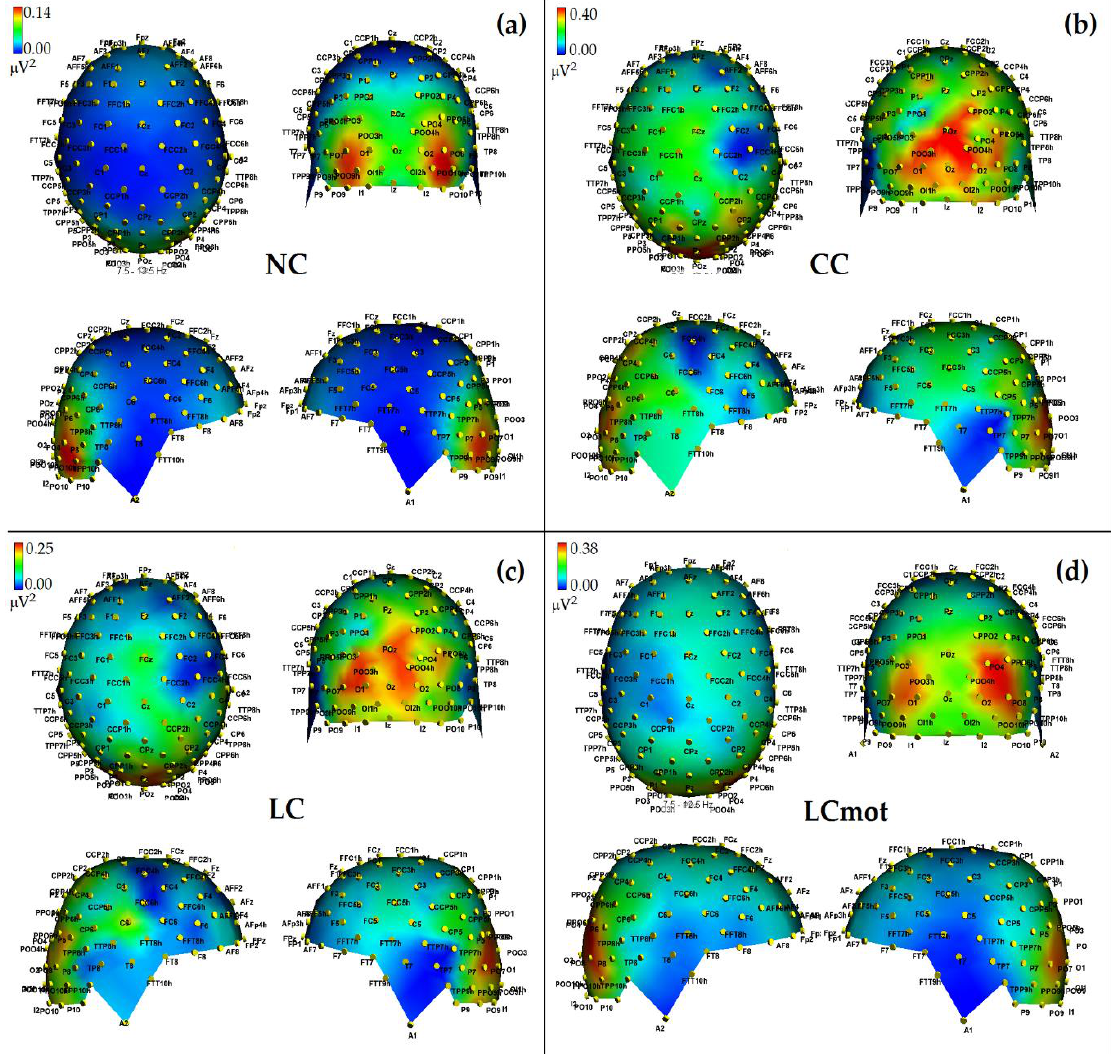
Figure 5. Three-dimensional (3D) maps of the topographical distribution of alpha power over the scalp as a function of the cueing-conditions grand-averaged over the respiratory conditions, and drawn from the top, the back, the right, and the left points of view, respectively. Time = 0 to 1500 ms, frequency = 7.5–12.5 Hz. ( a ): NC condition; ( b ): CC condition; ( c ): LC condition; ( d ): LCmot condition. Note that the scale of alpha power values (in µ V 2 ) is unalike in the di ff erent attentional-cueing conditions. Note also that while the alerting but spatially unpredictable, exogenous-orienting of attention to target (CC) condition showed the highest alpha power, the fully uncued, exogenous-orienting of attention to target (NC) condition was characterized by the lowest alpha power.